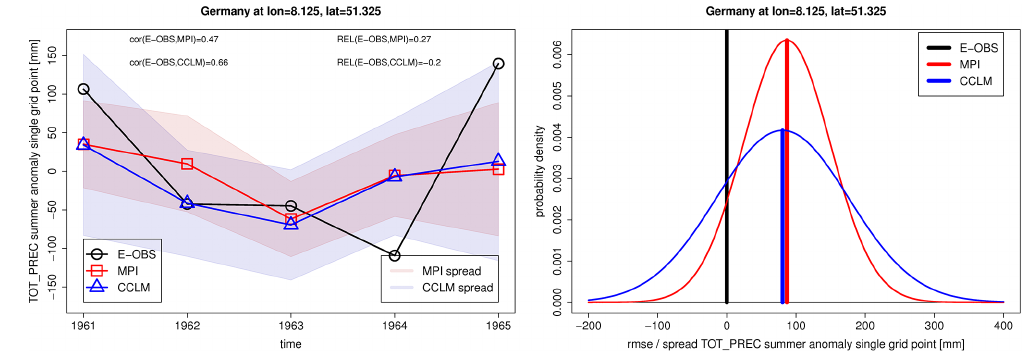
Figure 2. Snapshot from our time series showing the “added value” of downscaling, based on real